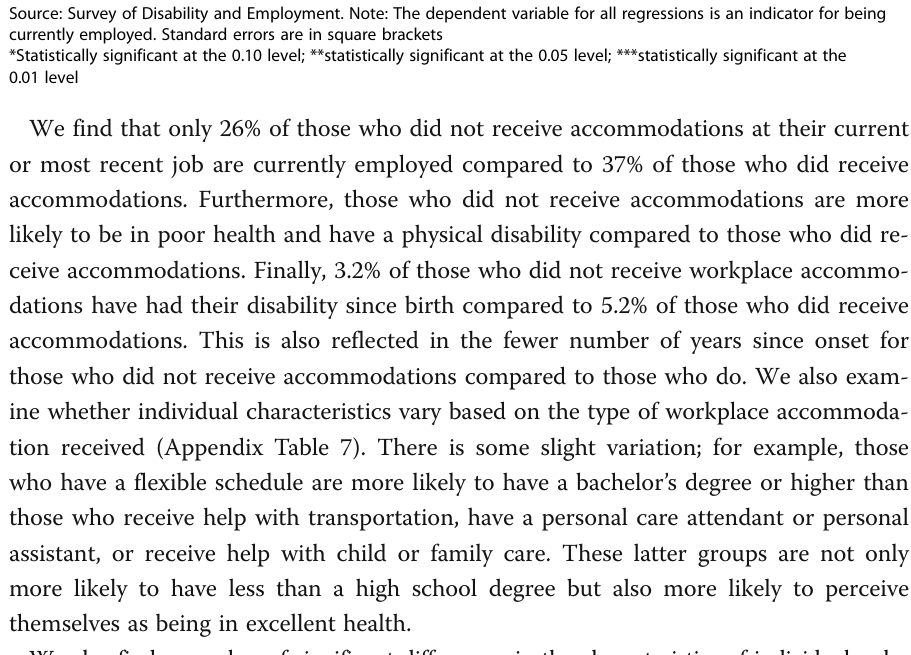
Perseveres until task is